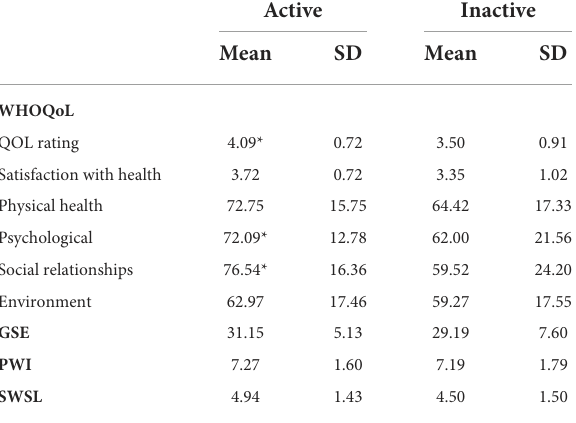
TABLE 2 WHOQoL, GSE, PWI, and SWSL